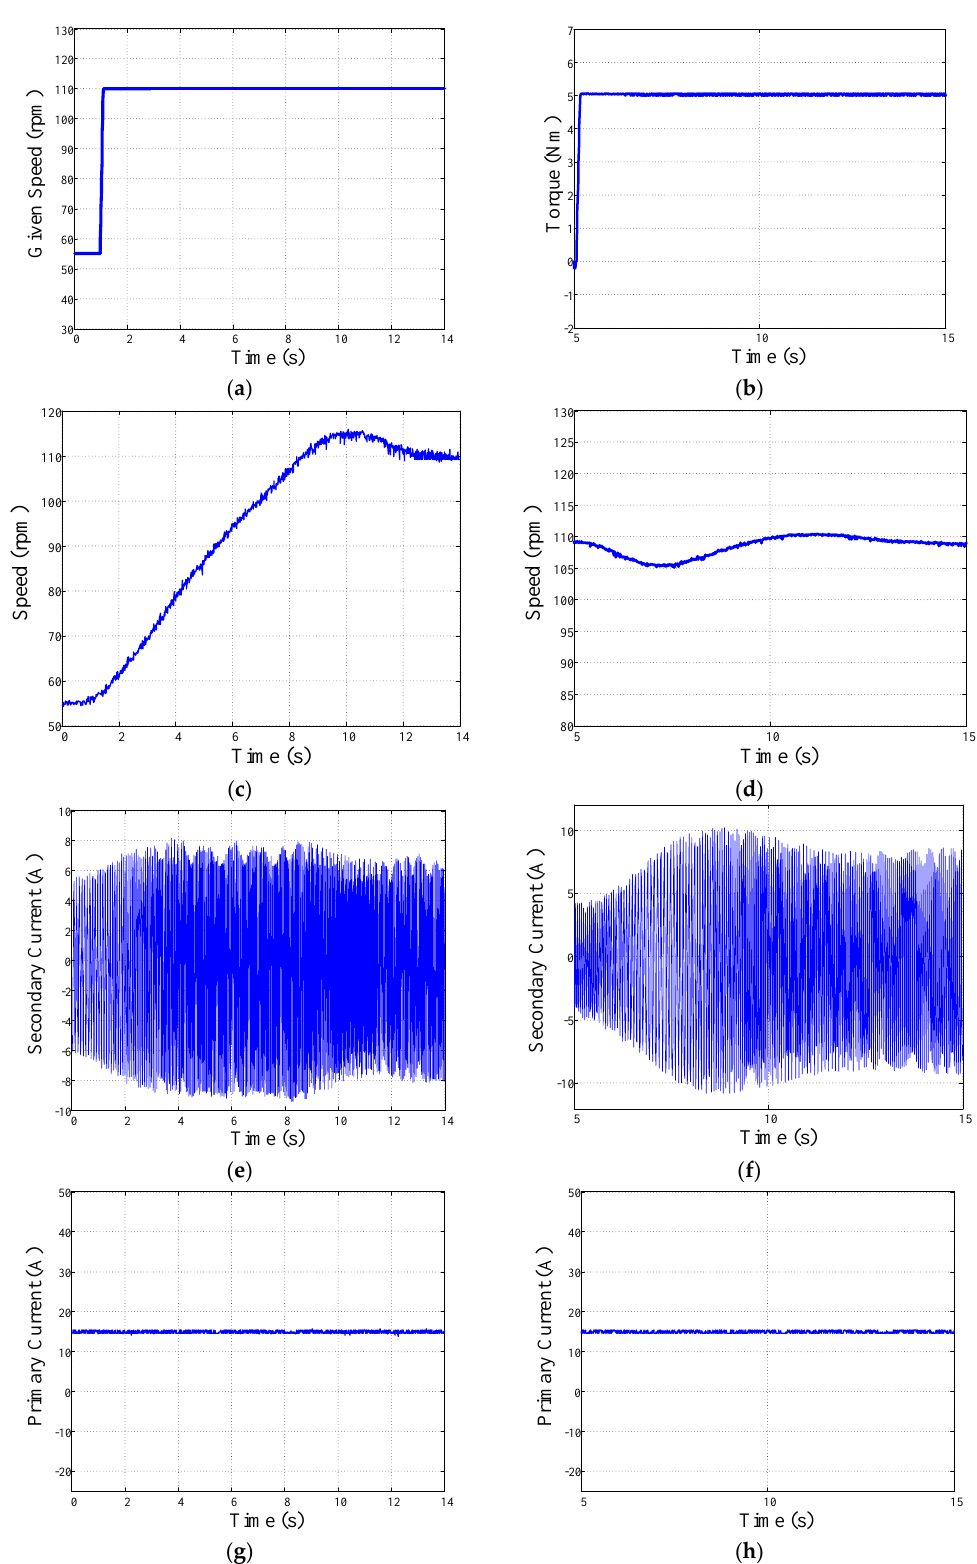
Figure 12. Experimental results of the DC excitation control for the DSFM motor: ( a ) curve of the given speed variation; ( b ) curve of the load torque variation; ( c ) speed curve for speed varying from 55 to 110 rpm; ( d ) speed curve for torque varying from 0 to 5 Nm; ( e ) secondary current curve for speed varying from 55 to 110 rpm; ( f ) secondary current curve for torque varying from 0 to 5 Nm; ( g ) primary current curve for speed varying from 55 to 110 rpm; and ( h ) primary current curve for torque varying from 0 to 5